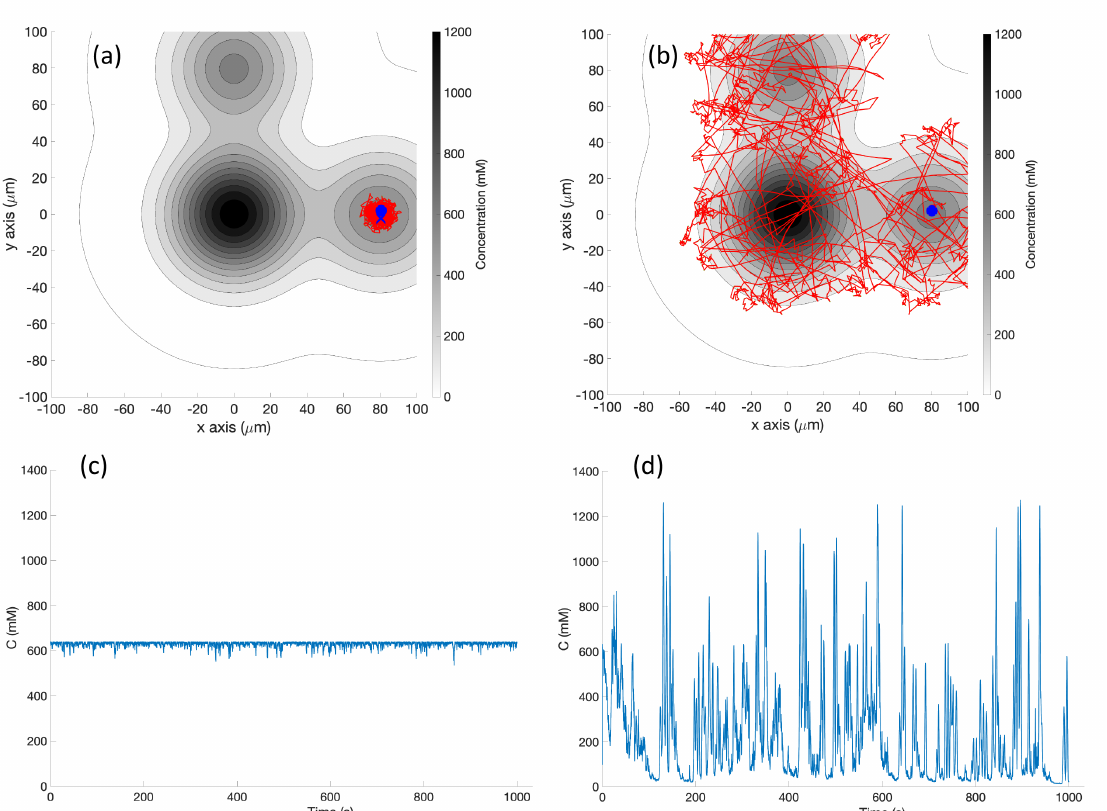
Figure 12. Case 3: Without obstacles in the environment and with triple effluents, the trajectories of the simulated robot running ( a ) the basic chemotaxis controller on the xy plane, ( b ) the RapidCell chemotaxis controller. ( c , d ) show the recorded concentrations associated with each scheme, respectively. The contour plot represents the concentration distribution shown in Figure 3 (right) where the outmost level curve represents the concentration at 1m M . The same region of interest of 200µm × 200µm was used for this environment. Thus, only trajectories within that region of interest are